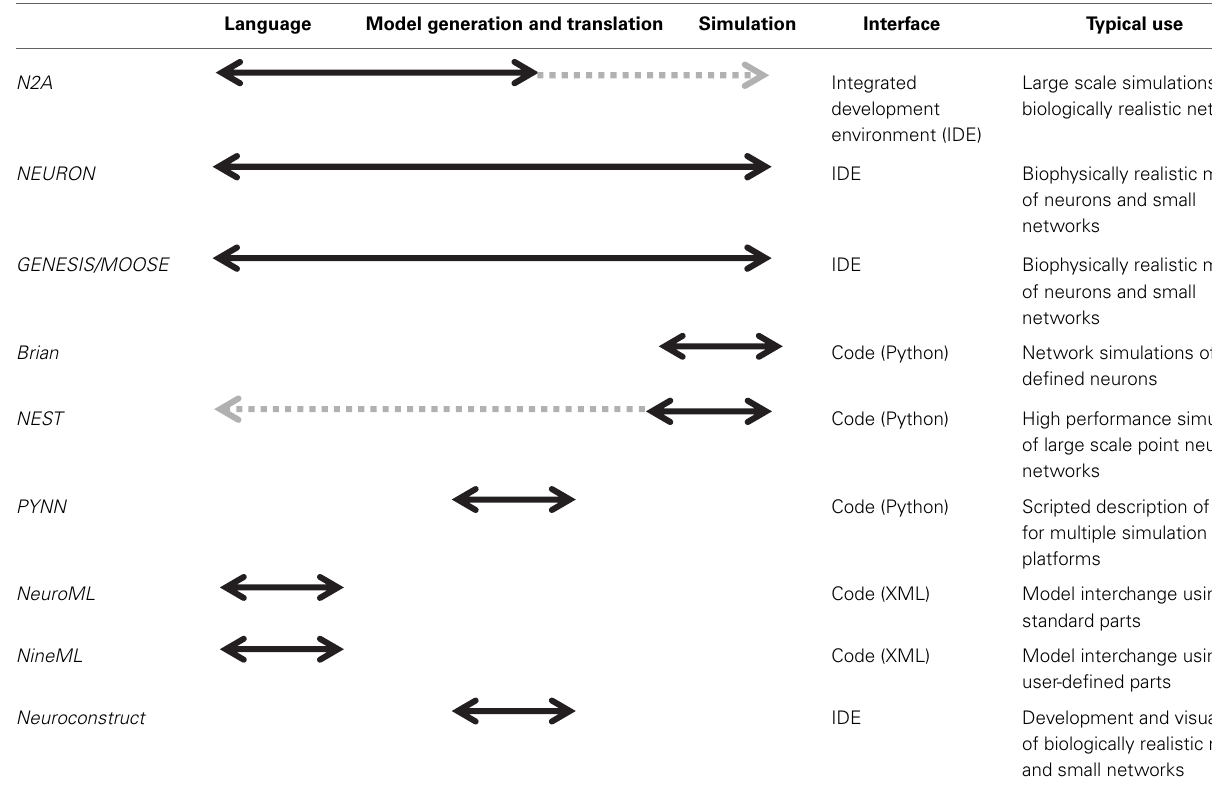
Table 1 | Overview of different neural modeling tools.